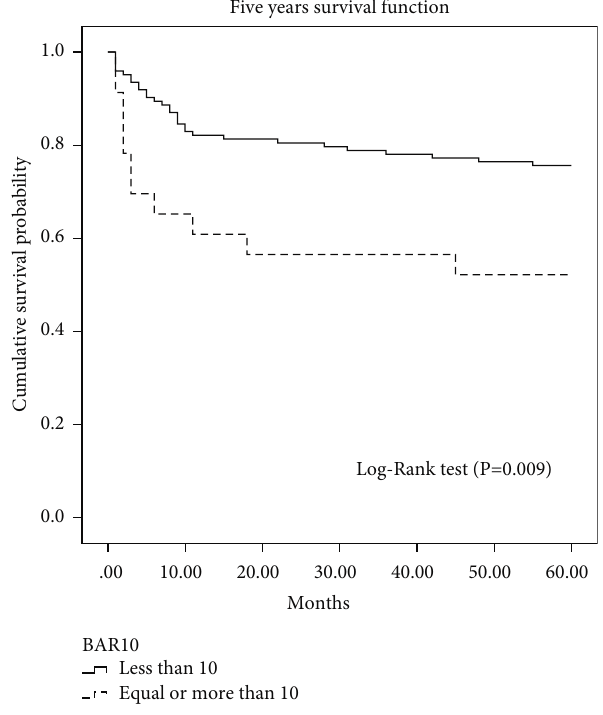
Post-transplant cumulative 5-year survival (Kaplan–Meier curve with log-rank test) for patients with the BAR score < and ≥ 10 points. BAR, balance of